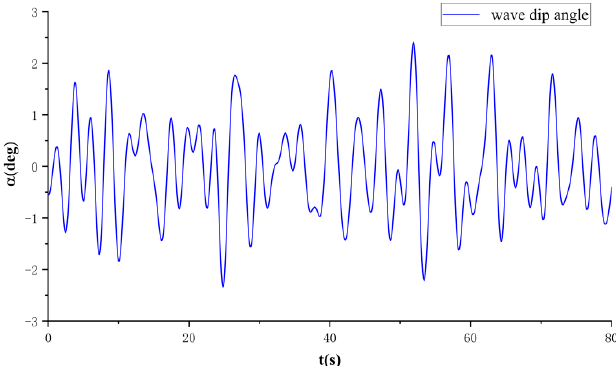
Figure 9. Wave-dip angle diagram.